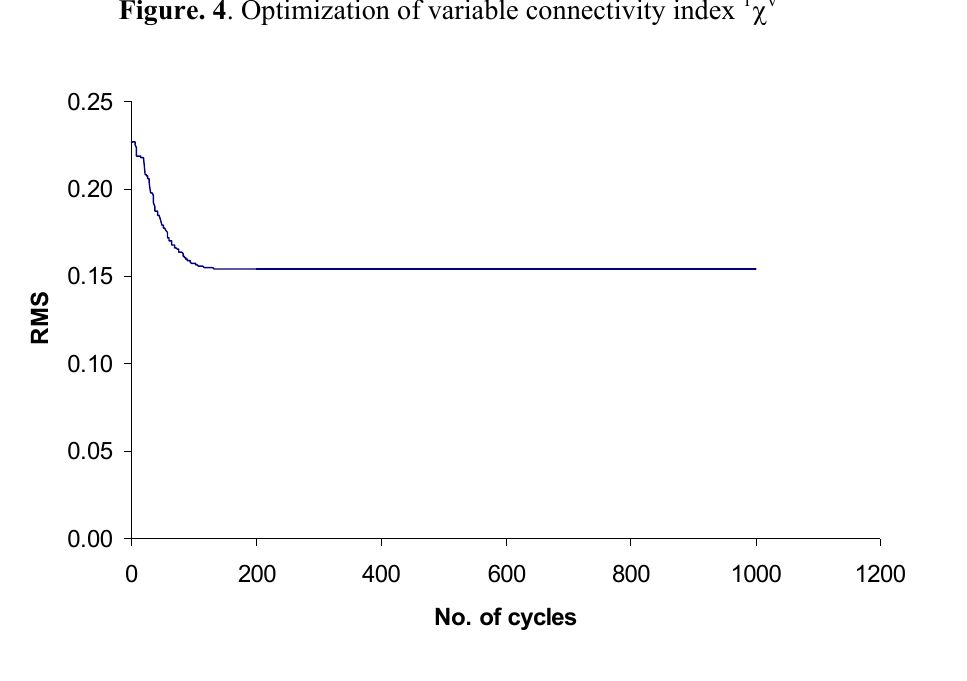
Figure. 4 . Optimization of variable connectivity index 1 χ